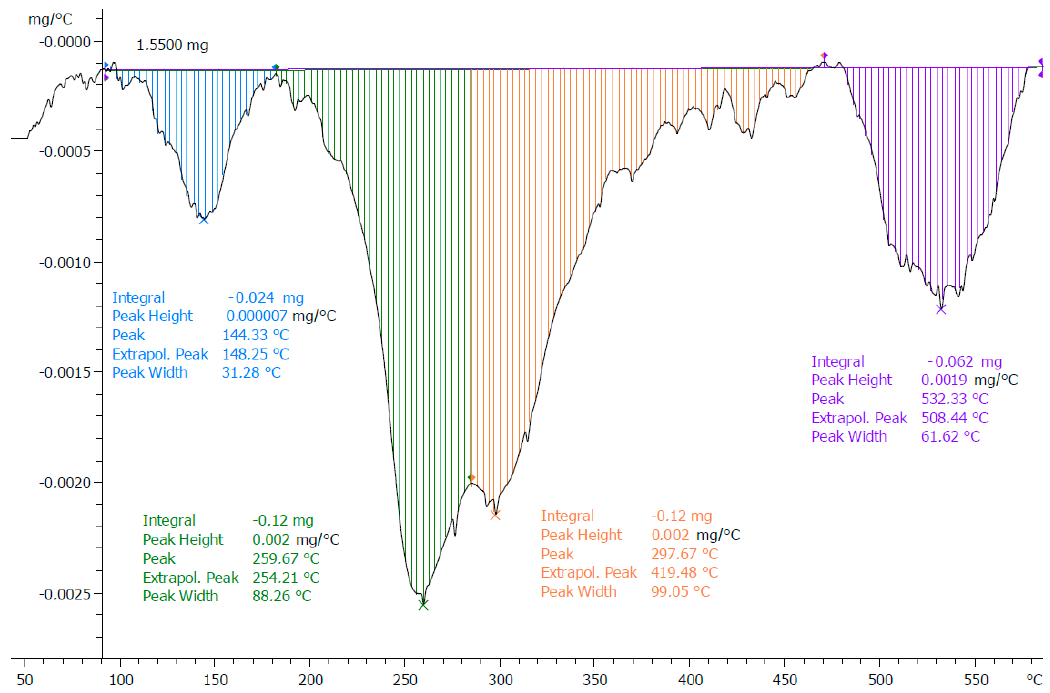
Figure A5. AuNP-RGD 7 with mass loss of 27.89%. Furan-PG (blue) is left with 2.11% mass loss. Instead, the RGD-ligands (purple) are responsible for 5.91% mass loss.